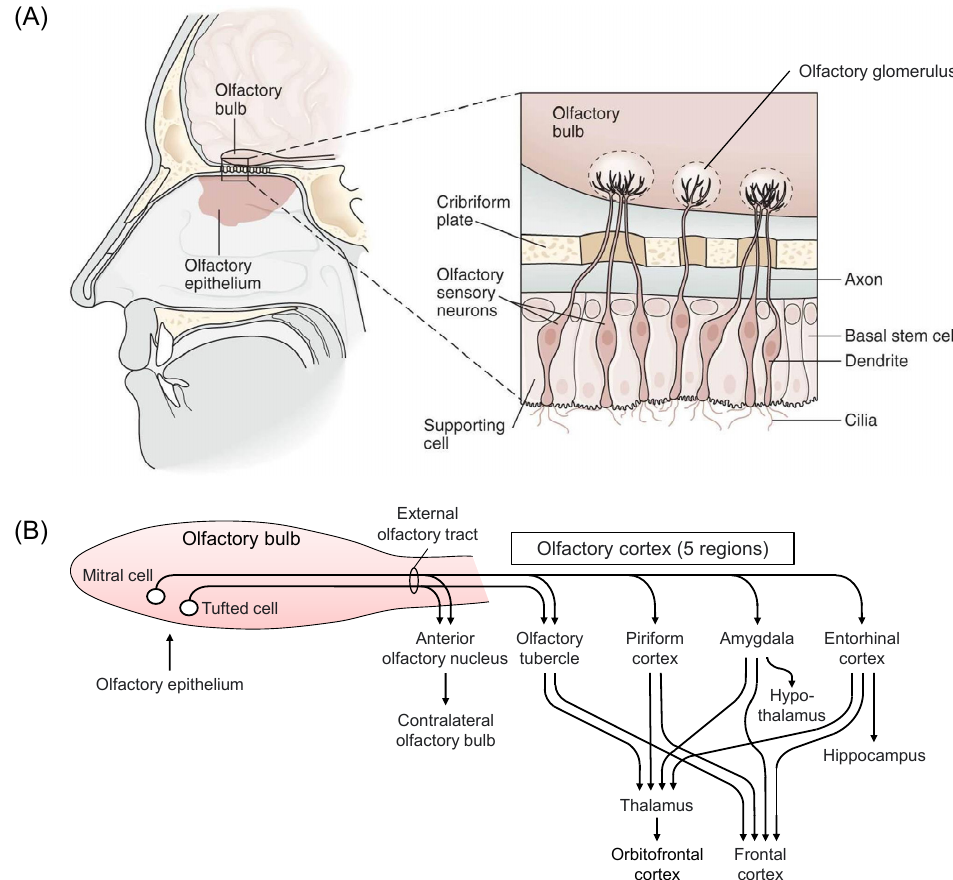
Figure 2. The human olfactory system. ( A ): Structure of the olfactory epithelium. There are 50 million olfactory sensory neurons in the nasal olfactory epithelium. Each neuron expresses one type of olfactory receptors on the cilia protruding toward the nasal cavity. From the other side of the neuron, an axon projects into the olfactory glomerulus in the olfactory bulb, where it synapses with the dendrites of the mitral and tufted cells. ( B ): Diagram of the olfactory pathway. Mitral cells project to the five regions, and tufted cells project to two regions in the olfactory cortex. Four regions connect to the thalamus and frontal cortex. Conscious discrimination of smell depends on the orbitofrontal and frontal cortices. Emotive aspects of olfaction derive from limbic projections (amygdala and hypothalamus). Thus, olfactory information may be closely related to memory and emotion, which affects stress response. This figure is derived from Kandel, E.R.; Schwartz, J.H.; Jessell, T.M. (Eds) Principles of Neural Science, 4th ed. McGraw-Hill, New York, NY, USA, 2000 [39] with a copyright